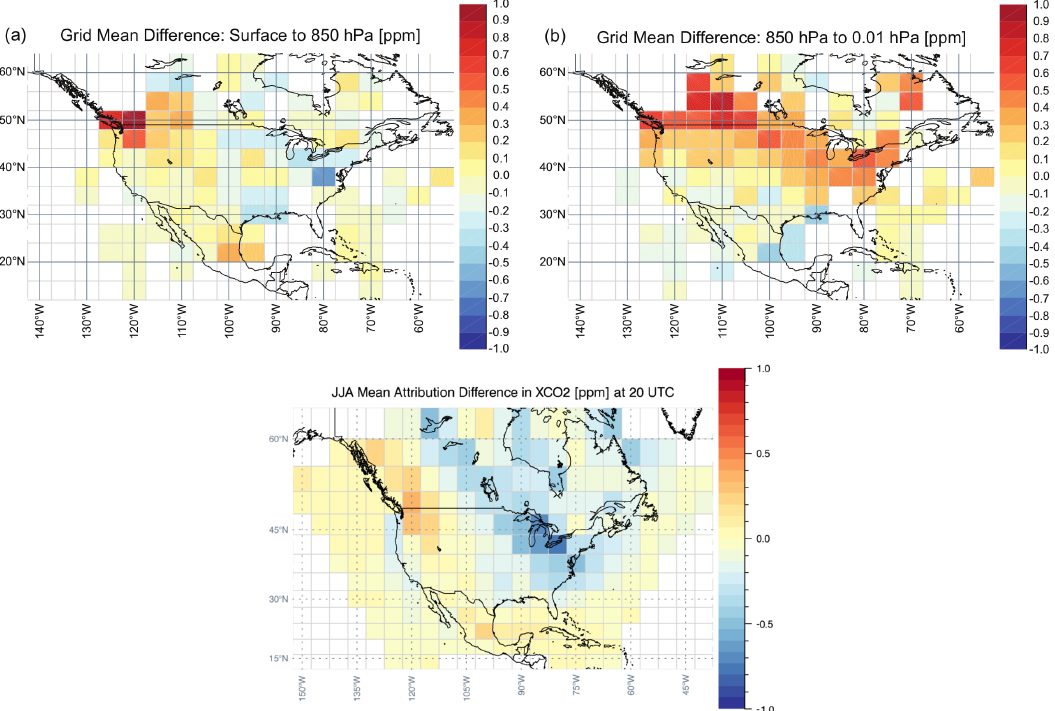
Figure 7. Mean summer (June, July, August) spatial differences in WRF and CMS-Flux pressure-weighted CO 2 for partial columns of simulated GOSAT XCO 2 aggregated to the CMS-Flux grid (light gray lines). ( a ) Lower portion of column (model surface to 850 hPa) ( b ) Upper portion of column (850 hPa to top of the ACOS profile) and ( c ) the differences in the lower portion of the column scaled to the total column mole fractions (lower